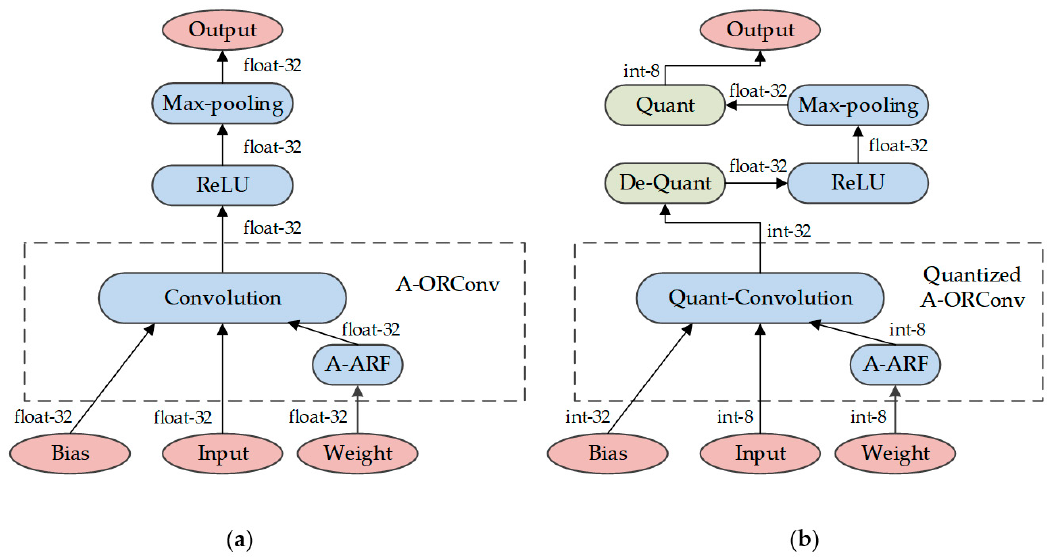
Figure 3. The comparison between the convolutional layer with the A-ARFs (A-ORConv) and quantized A-ORConv layer. ( a ) The calculation process of the A-ORCov layer; ( b ) The calculation process of the Quantized A-ORConv layer. ‘Quant’ and ‘De-Quant’ refer to ‘quantized’ and ‘de-quantized’,